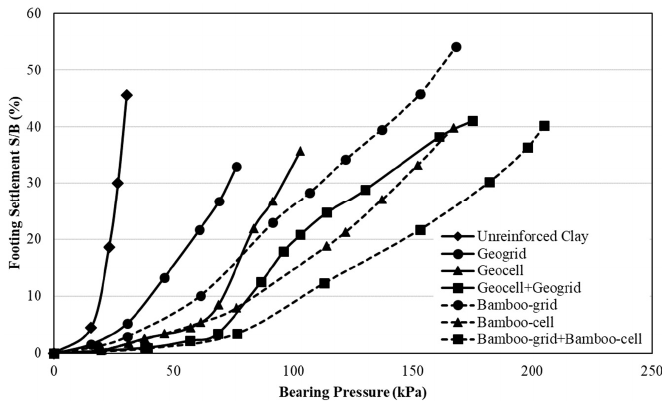
Figure 6. Comparison of bearing pressure-settlement curves of different bamboo oriented distributed fiber-reinforced soil (ODFS) reinforcement techniques (Data sourced from Reference [65]).